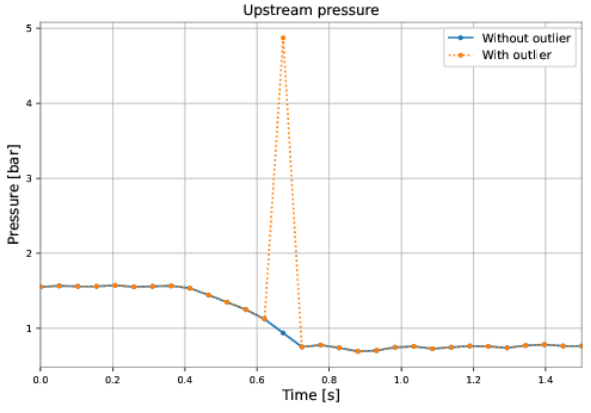
Figure 40. Example of pressure